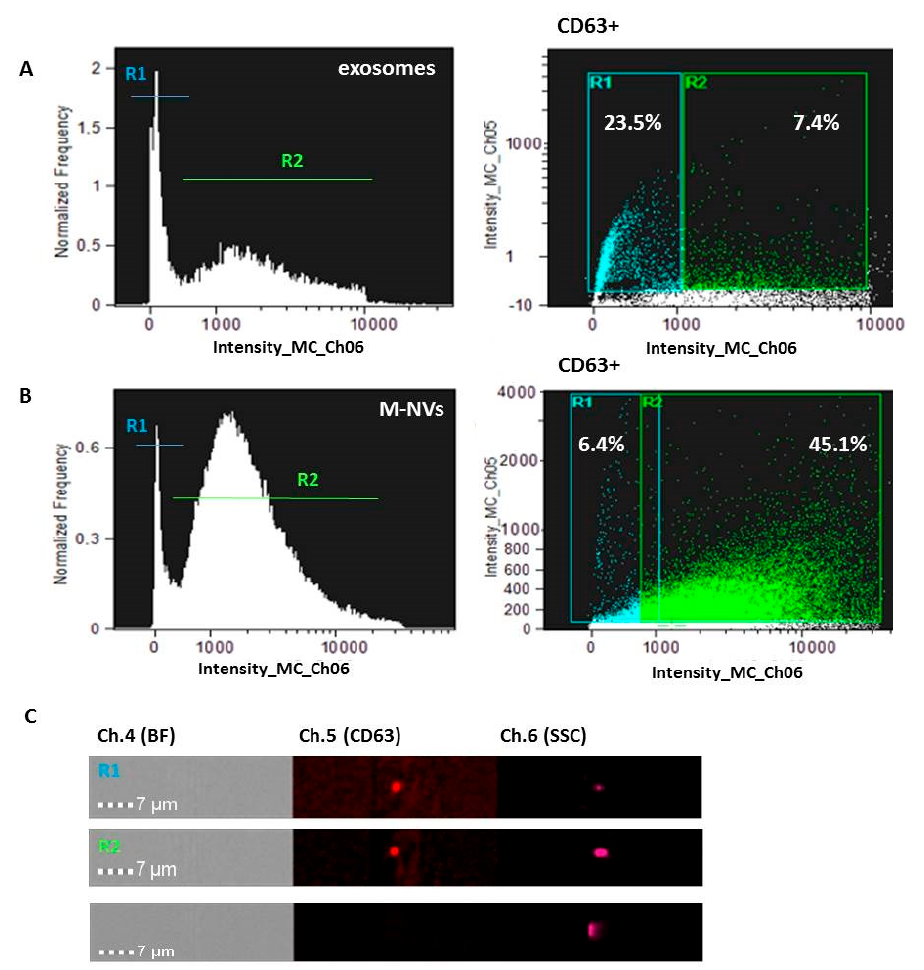
Figure 3. CD63 expression in R1 and R2 sub-populations from T98G exosomes ( A ) and M-NVs ( B ) by Amnis ImageStreamX MarkII flow cytometer. Examples of CD63 + and CD63- (Ch.5) EVs (60×)